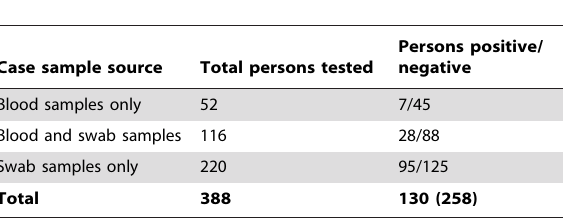
Table 2. MLU Sample source and test